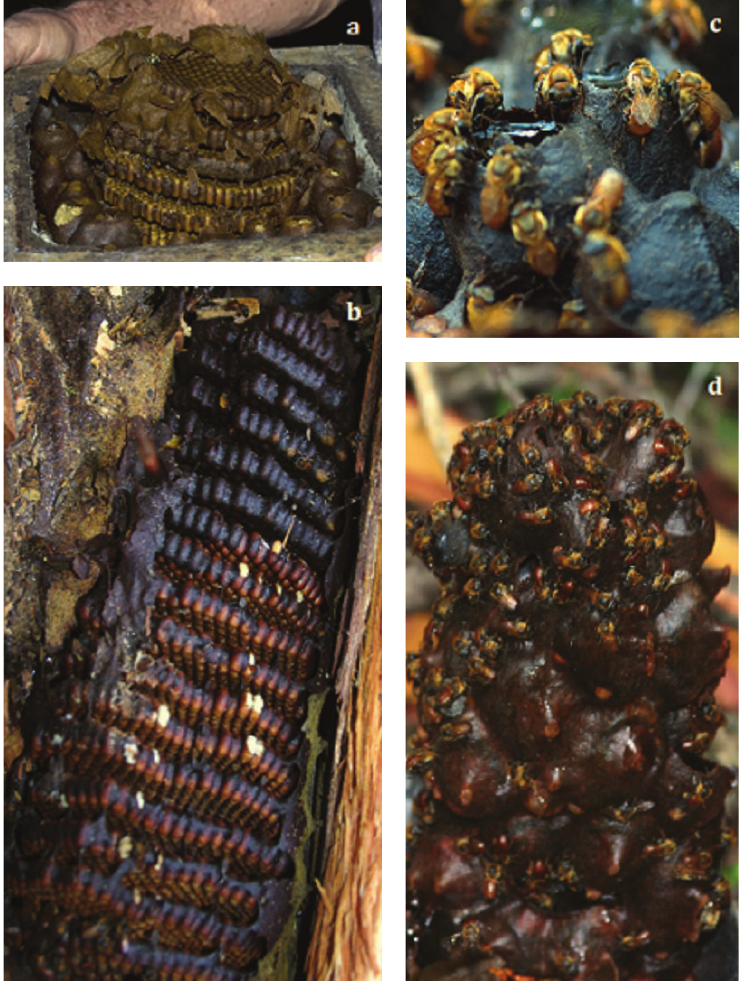
Figure 2: Colony conditions. (a) Colony in standard box, with large brood combs and surrounding pollen-pots; (b) colony inside tree- trunk with many brood combs, the age of developmental stage increases from upper to down, well evidenced by the darker color of combs in initial development; (c) workers of Melipona seminigra merrillae in honey-pots; (d) honey and pollen pots provision of the tree-trunk colony showed in (b) and many workers feeding